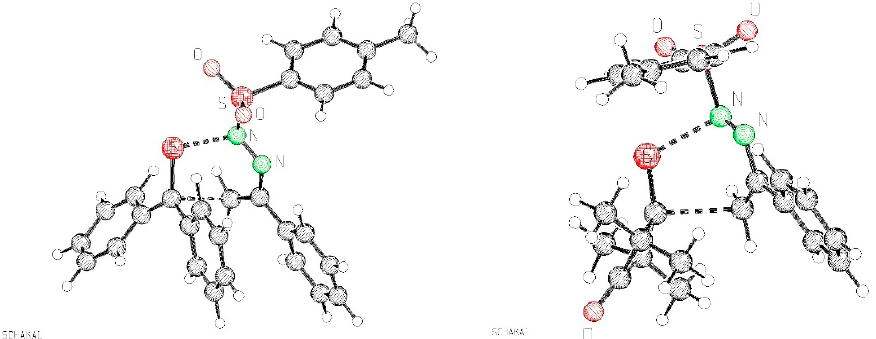
Figure 3. Van der Waals complex of azoalkene 7a and thiobenzophenone ( 1a ) ( left side) and its transition state A ( right side) leading to 1,3,4-thiadiazine derivative 9a .